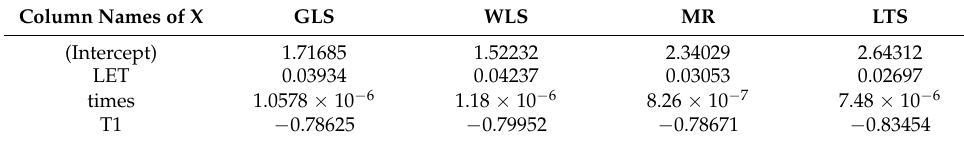
Table 5. Estimation parameters for training set under different methods.